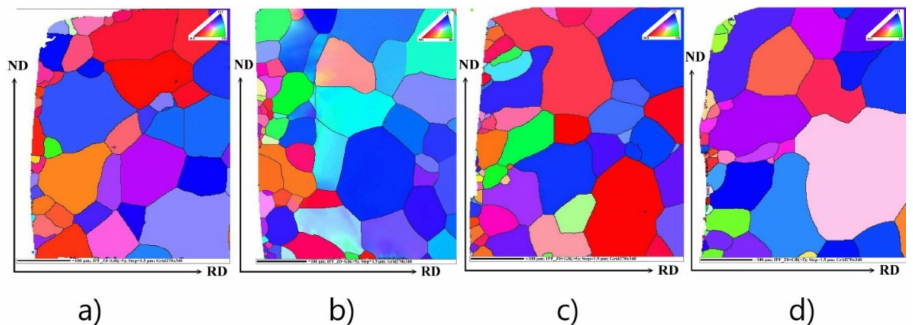
Figure 6. IPF maps present the characterization of the textural state near the cutting edge of rings with cutting clearances corresponding to 1% ( a ), 3% ( b ), 5% ( c ), 7% ( d ) of the sheet thickness after annealing. The colour key for the identification of crystallographic orientation of grain is located in the upper right corner of the IPF